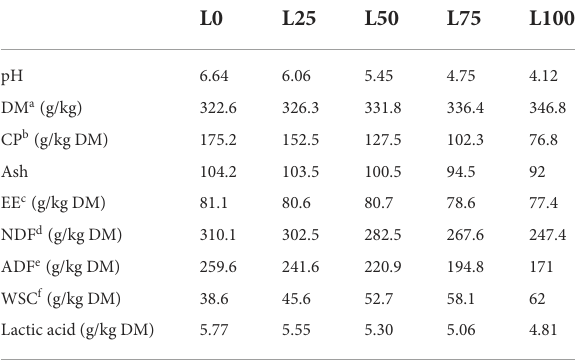
TABLE 1 Chemical composition of raw materials before